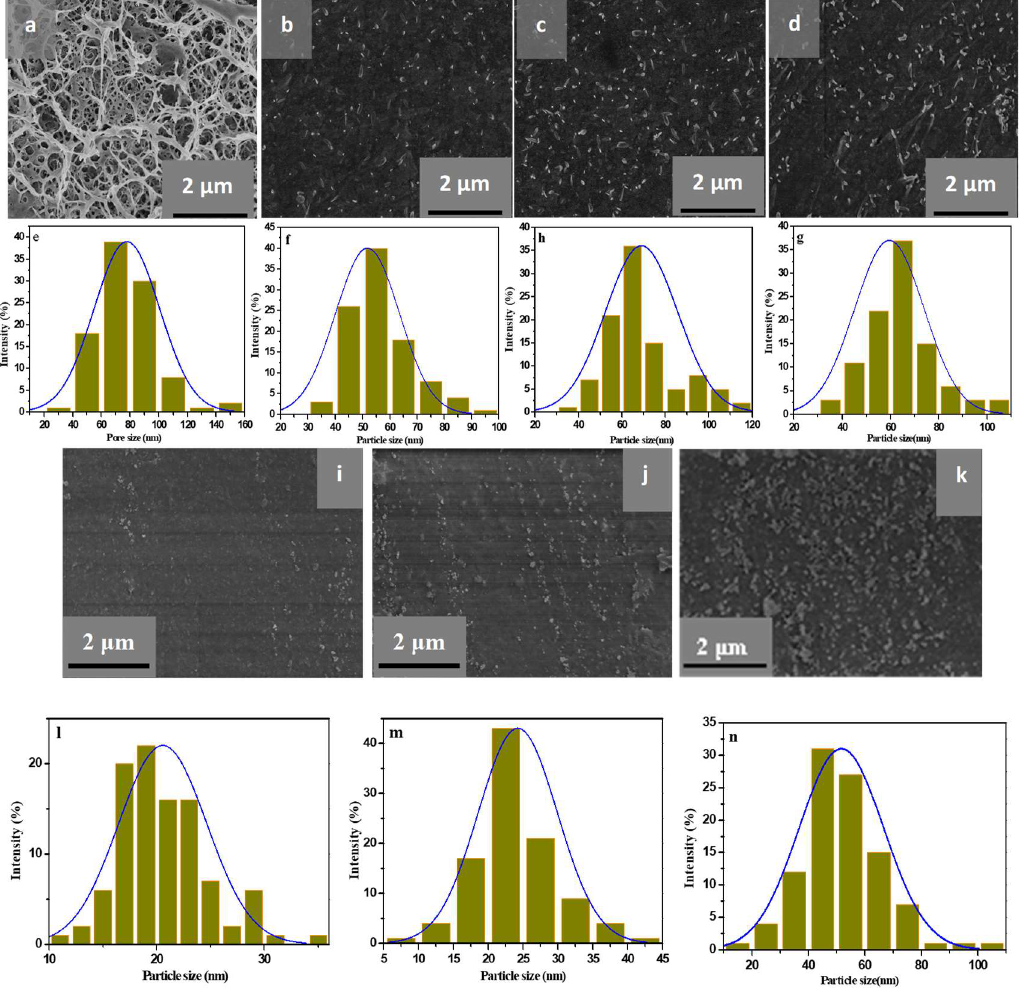
Figure 4. SEM image ( a ) and particle size histogram ( e ) of the surface of RC; SEM images and particle size histograms of the surface of RC-0.1 ( b , f ); RC-0.2 ( c , g ); RC-0.5 ( d , h ) and the cross-section of RC-0.1 ( i , l ); RC-0.2 ( j , m ); RC-0.5 ( k , n ).